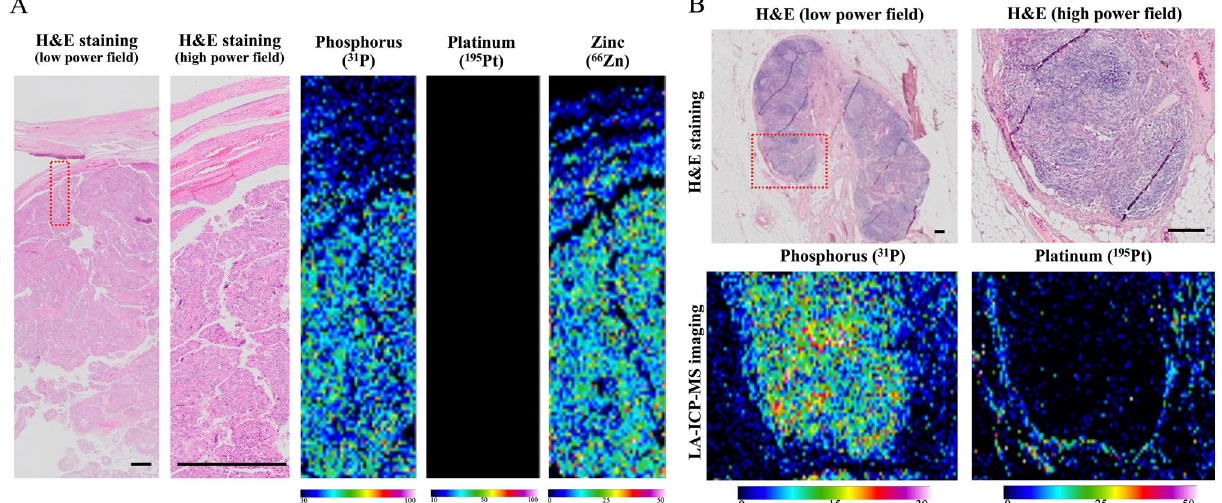
Figure 2. Phosphorus and platinum distributions in clinical samples using laser ablation ICP-MS (LA-ICP-MS). ( A ) Representative LA-ICP-MS images of high-grade serous ovarian cancer in primary debulking surgery as a negative control of the platinum and phosphorus and zinc distribution in tumor. Scale bar: 200 μm. ( B ) Images of phosphorus and platinum distributions in a clinically platinum-resistant recurrent ovarian tumor. Platinum was not present in the tumor but had accumulated in the borderline area of the tumor and stroma. Scale bar: 200